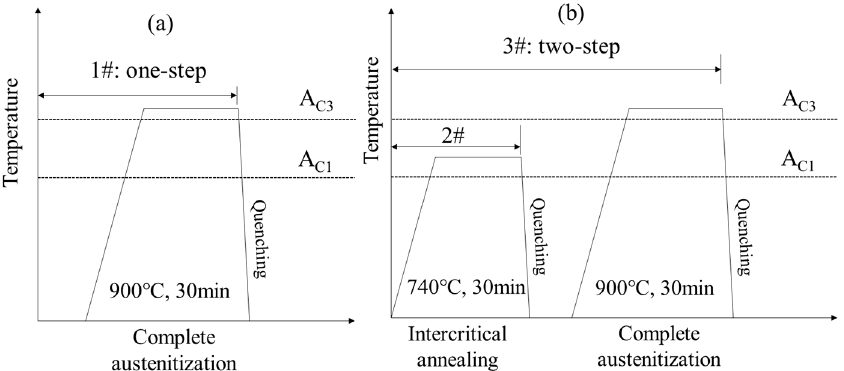
Figure 1. Heat treatment scheme of experimental specimens: ( a ) conventional quenching process; and ( b ) intercritical annealing, and intercritical annealing + conventional quenching processes.